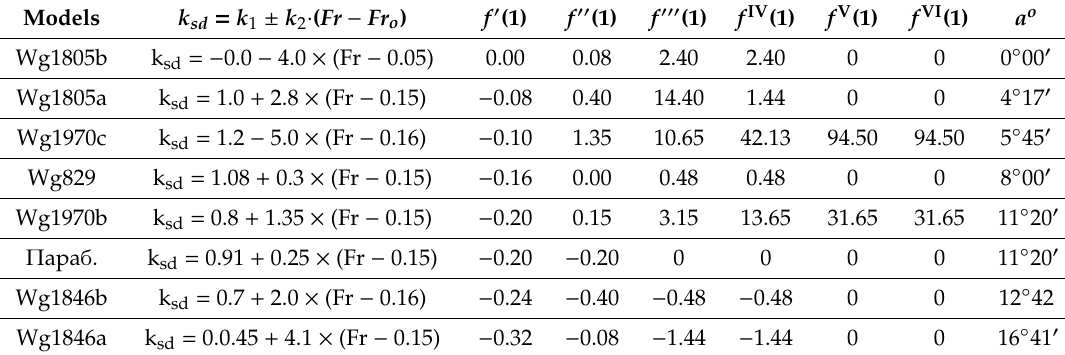
Table 3. Derivatives of the surface equations of the ship hull of Wigley’s models. Models